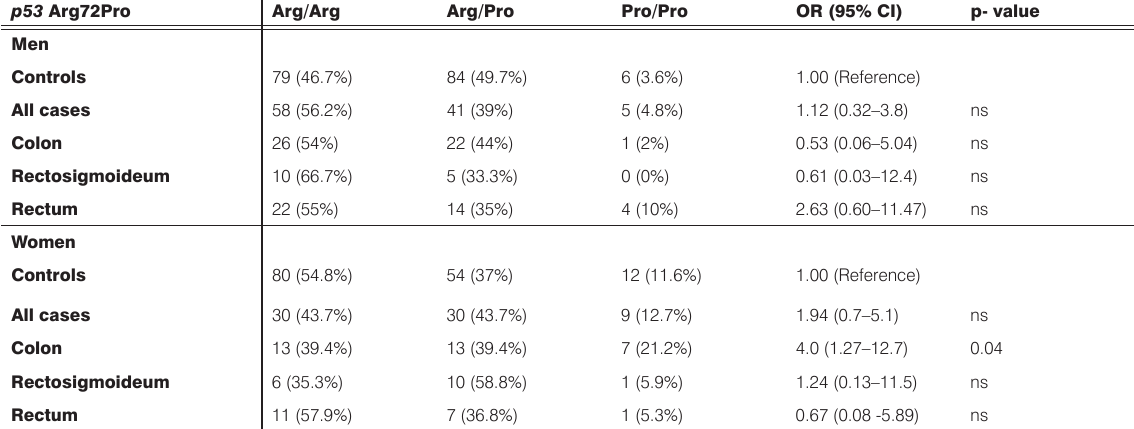
Table 4. Frequency distribution of p53 codon 72 polymorphism between cases and controls and its association with risk of colorectal cancer or selected diagnosis. p53 Arg72Pro